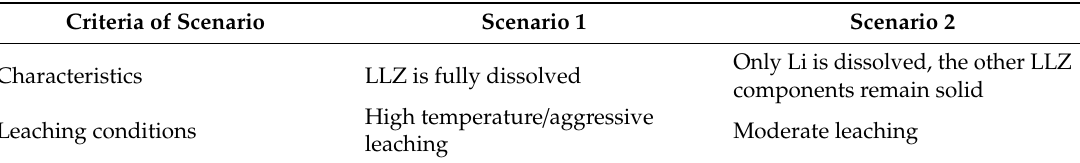
Table 3. Two hydrometallurgical recycling scenarios discussed within this